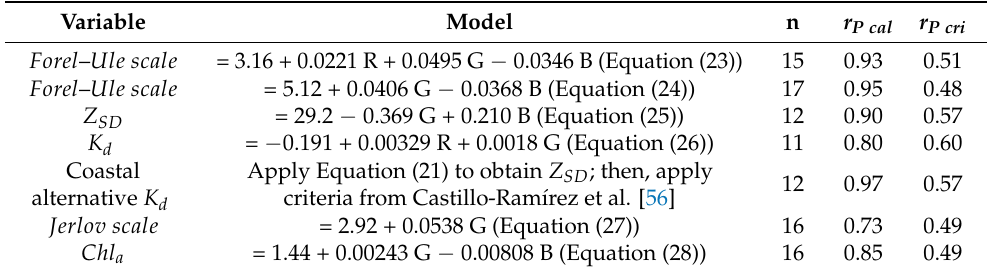
Table 7. Results of the model validation analysis for the oceanic and coastal